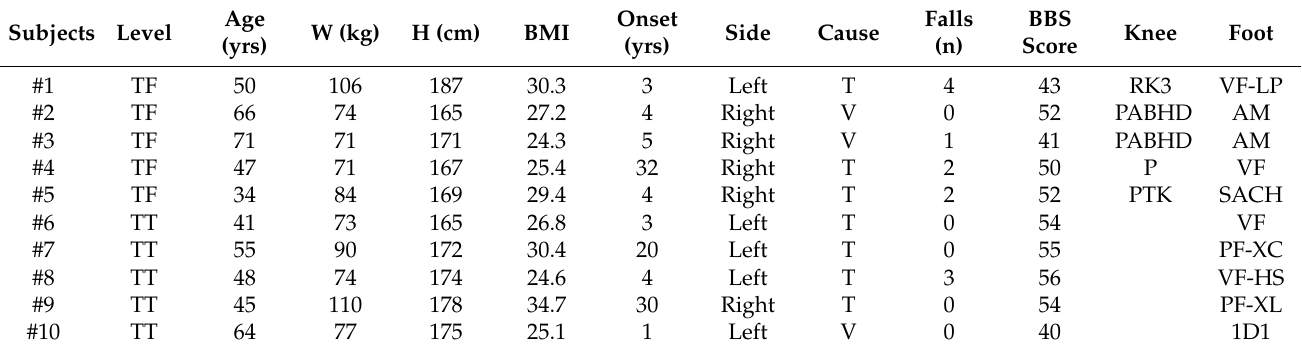
Table 2. Anthropometric and clinical data of the persons with lower limb